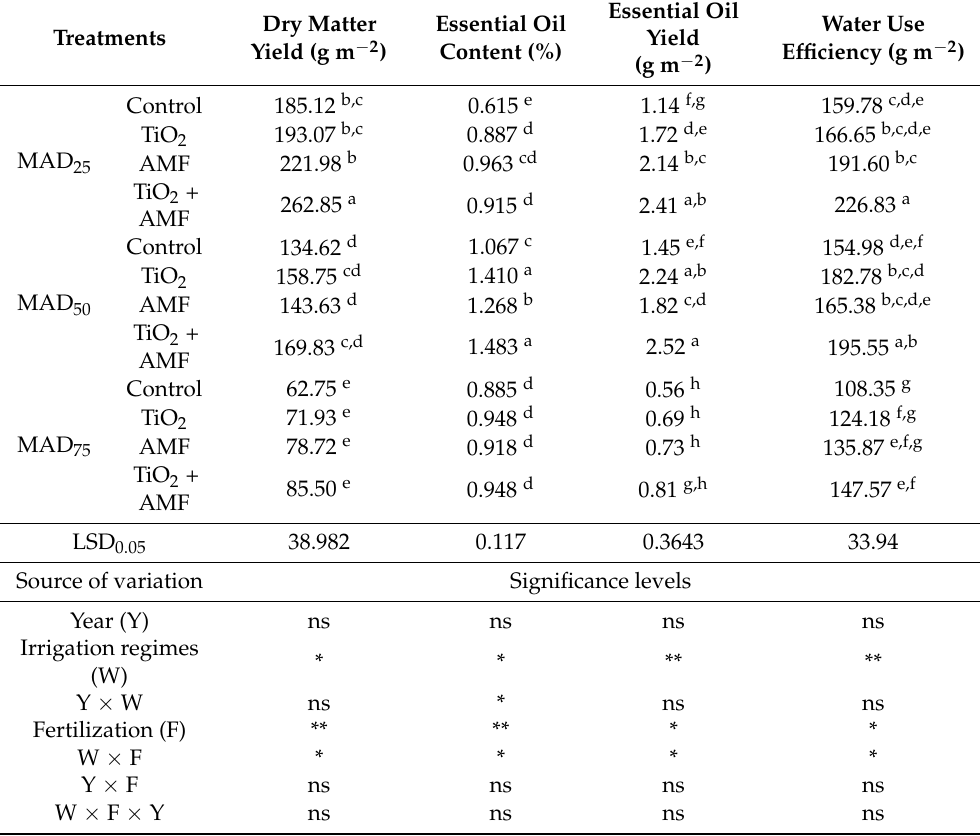
Table 2. The dry matter yield, essential oil content, essential oil yield, and water use efficiency of sage in different irrigation regimes and fertilizer